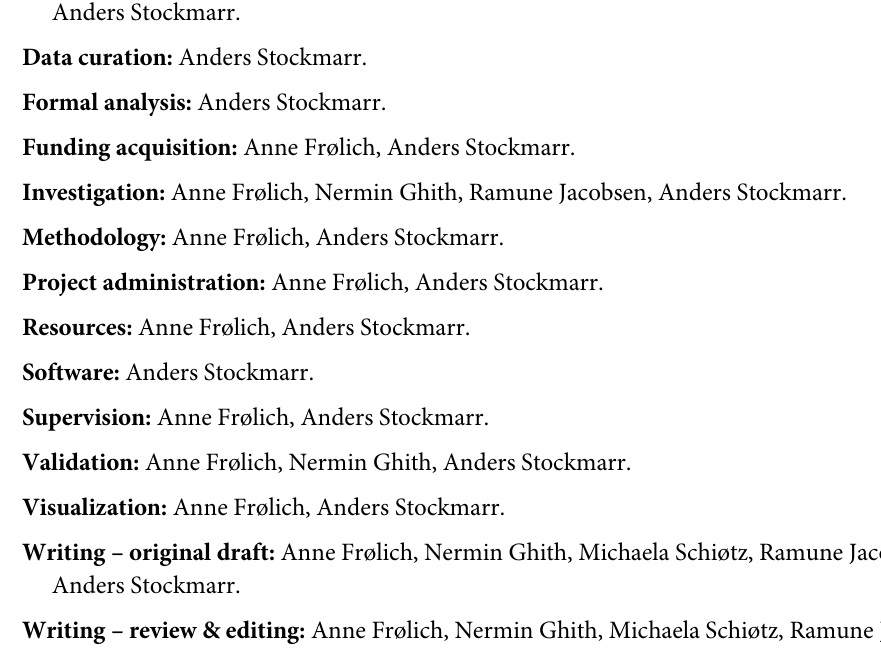
S1 Table. Algorithms used to define the 16